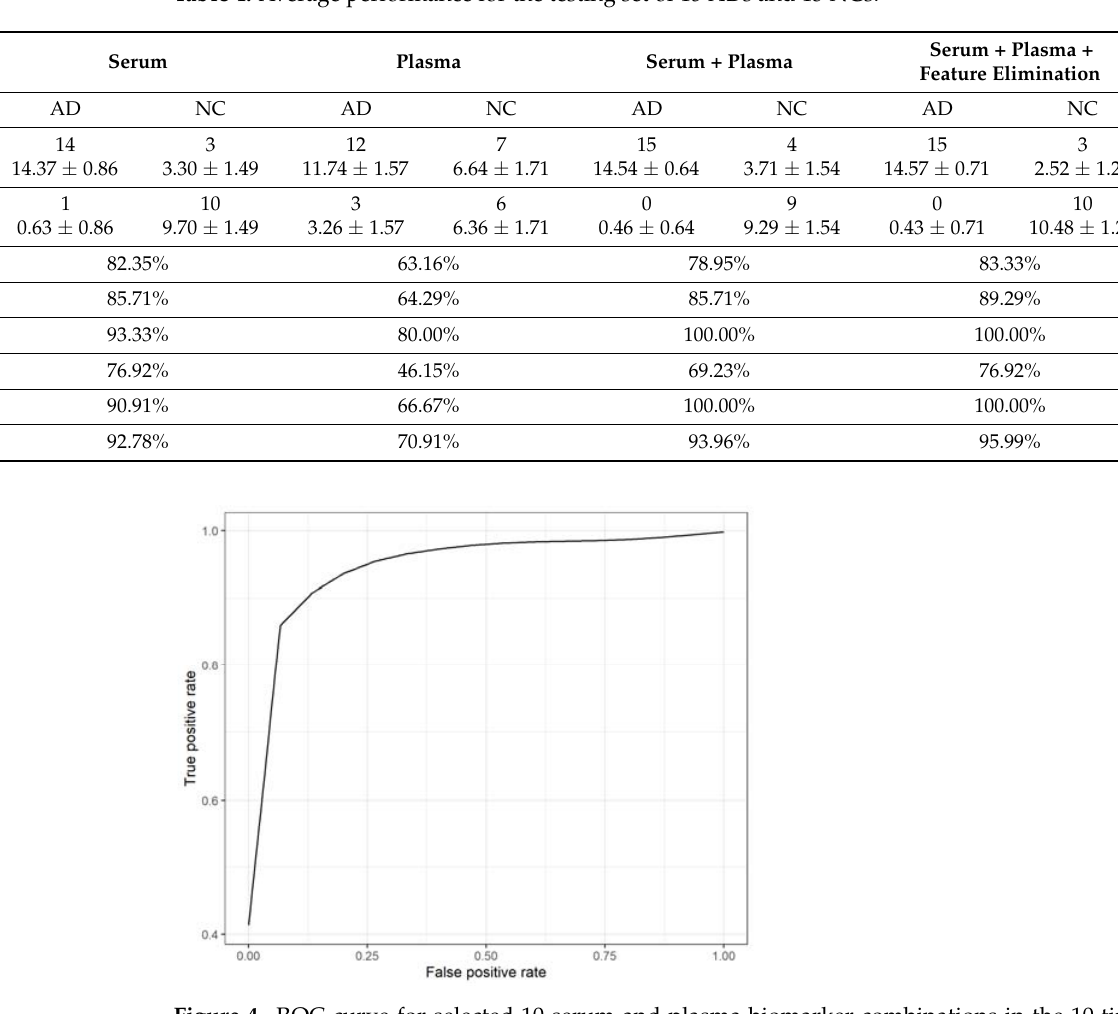
Table 4. Average performance for the testing set of 15 ADs and 13 NCs.